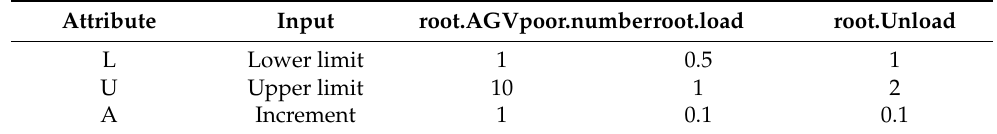
Table 8. Value-added definition of multilevel experiments.